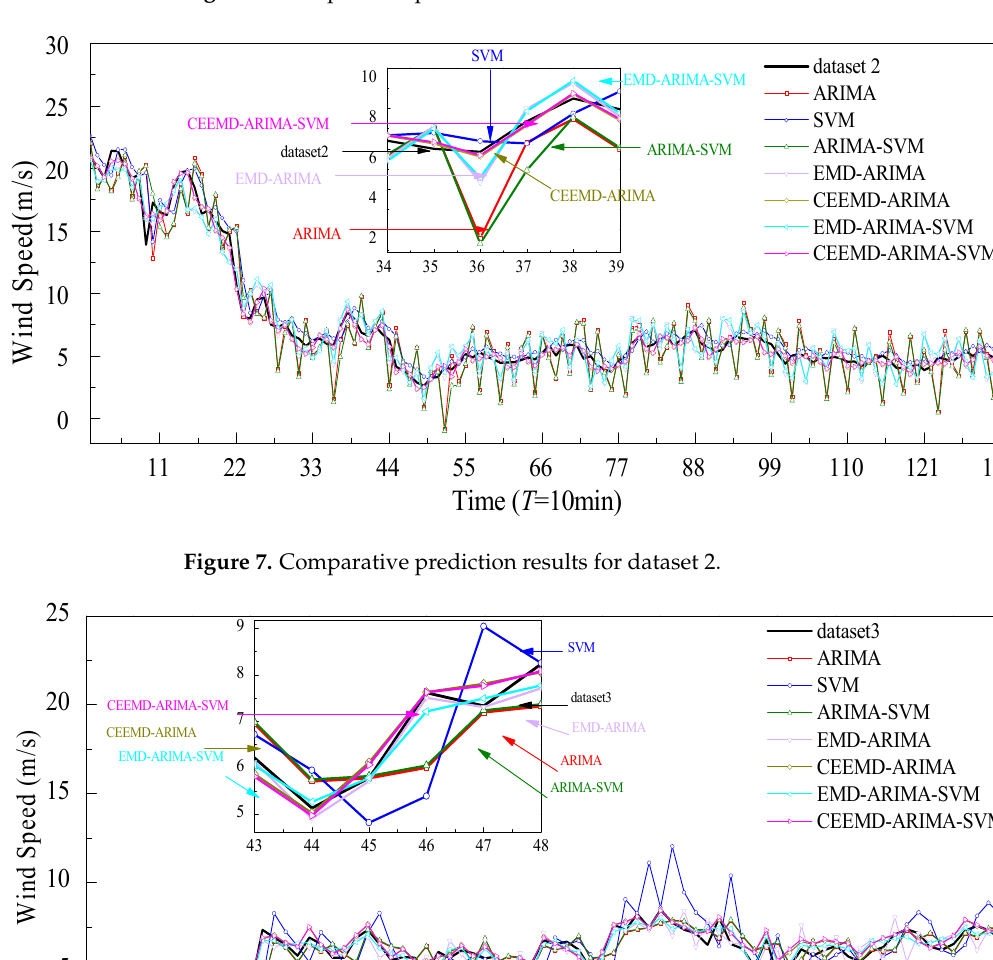
Table 2. Evaluation index results for the prediction models